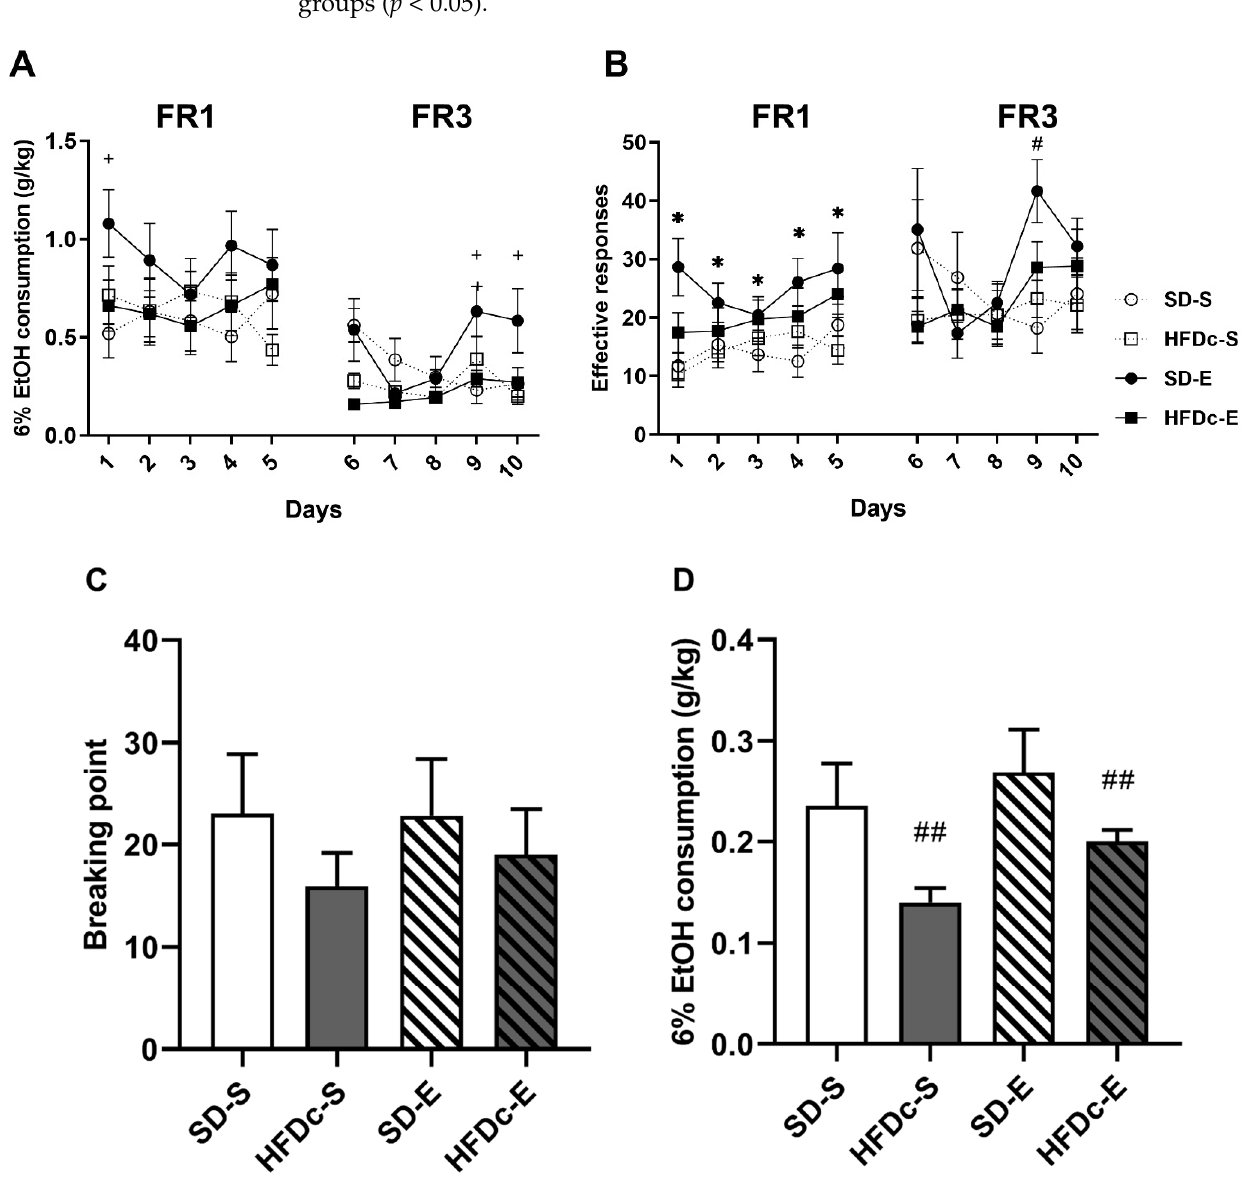
Figure 6. Effects of continuous access to high-fat diet (HFD) on effective responses and oral ethanol EtOH self-administration in OF1 mice. Data are presented as mean ( ± SEM): ( A ) g/kg of 6% EtOH consumption ( B ) the number of effective responses during FR1 and FR3. The columns represent means and the vertical lines ± SEM of ( C ) breaking point values during PR and ( D ) amount of 6% EtOH consumption during the PR session * p < 0.05 significant differences in the groups that received BD (SD-E and HFD-E) compared to the saline groups (SD-S and HFDc-S). + p < 0.05 significant differences between SD-E with respect to SD-S. # p < 0.05 significant differences between the BD-treated groups and the saline-treated groups in Day 9. ## p < 0.01 significant differences between the HFDc groups (HFDc-S and HFDc-E) compared to the SD groups (SD-S and SD-E).